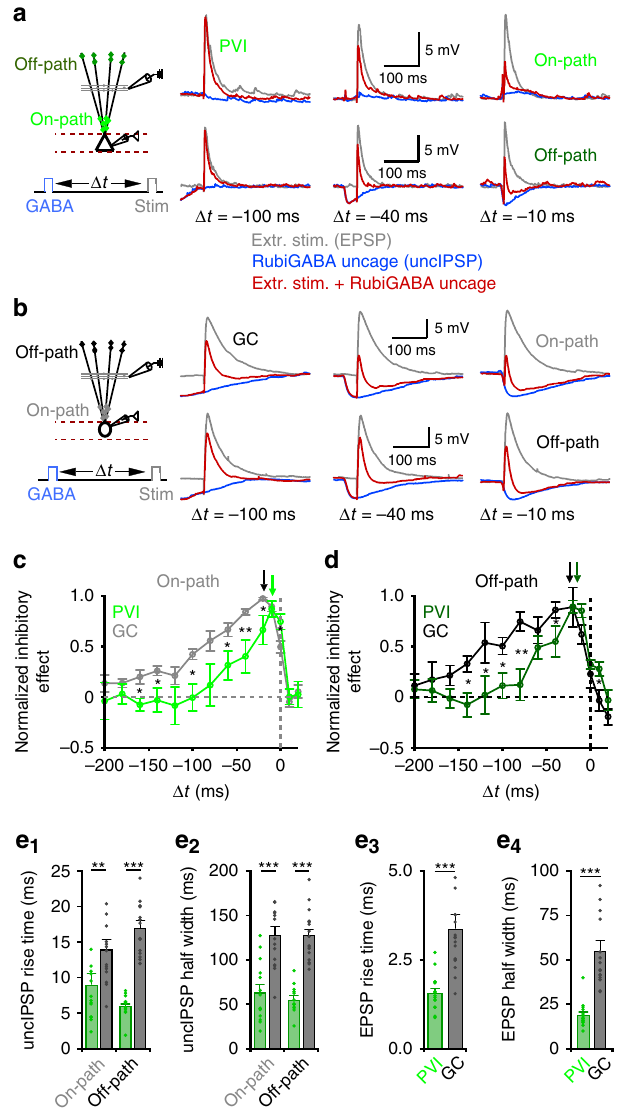
Fig. 8 Inhibition is more temporally precise in PVIs than in GCs. a , b Left, schematic illustration of the experimental design. EPSPs were evoked by extracellular stimulation of the middle molecular layer (~150 µ m distance from the soma) and recorded at the soma of PVIs ( a ) or GCs ( b ) in the absence or presence of dendritic inhibition. IPSPs were evoked by sequential RubiGABA uncaging (uncIPSPs) at seven dendritic positions randomly distributed on- (25 – 75 µ m distances to soma) or off-path (>200 µ m distance from the soma). EPSP amplitude was kept constant while the time window ( Δ t ) between the onset of RubiGABA uncaging and extracellular stimulation was systematically changed between − 200 and 20 ms. Right, superimposed representative traces of control EPSPs (gray), uncIPSPs (blue) and EPSPs in presence of uncIPSCs (red) for on-path (upper traces) and off-path (lower traces) inhibition at three different Δ t . c , d Summary plots show inhibitory effects of on-path ( c ) and off-path ( d ) inhibition for PVIs (bright and dark green, respectively; eight PVIs) and GCs (gray and black, respectively; 11 GCs) as a function of Δ t . Note, maximal inhibitory effects for on- and off-path inhibition were achieved at ~10 ms Δ t in PVIs and at ~20 ms Δ t in GCs. e 1 – 4 Bar graphs summarize functional properties of synaptically evoked EPSPs and uncIPSPs. Note, signals are faster in PVIs (green) compared to GCs (gray). Bars with lines and circles with lines represent mean ± s.e.m. * p ≤ 0.05; ** p ≤ 0.01; *** p ≤ 0.001.